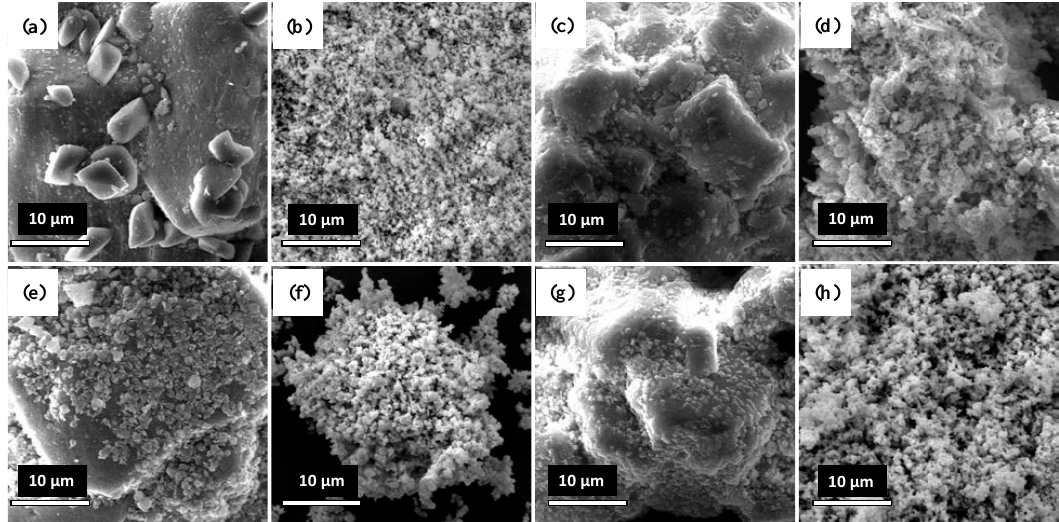
Figure 7. SEM images for RhMo/ ɣ -Al 2 O 3 ( a ) oxide, ( b ) sulfided; RhMo-EDTA/ ɣ -Al 2 O 3 ( c ) oxide, ( d ) sulfided; RhMo-AA/ ɣ -Al 2 O 3 ( e ) oxide, ( f ) sulfided; RhMo-CA/ ɣ -Al 2 O 3 ( g ) oxide, ( h ) sulfided catalysts.